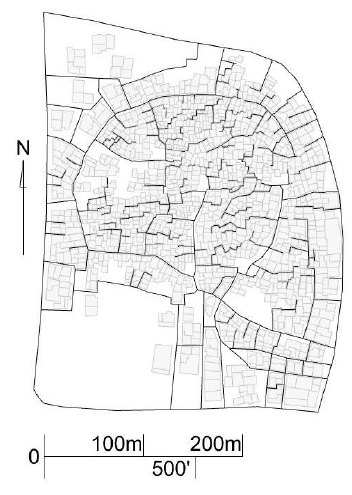
Figure 1. View of Balat town showing the earthen architecture and the compact vernacular urban fabric.